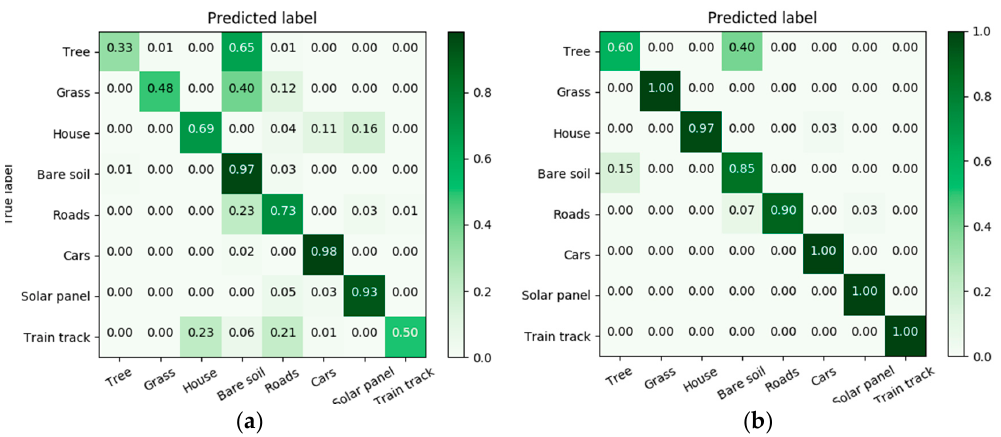
Figure 10. Confusion matrices for Trento → Toronto: ( a ) NN; ( b ) Siamese-GANs.